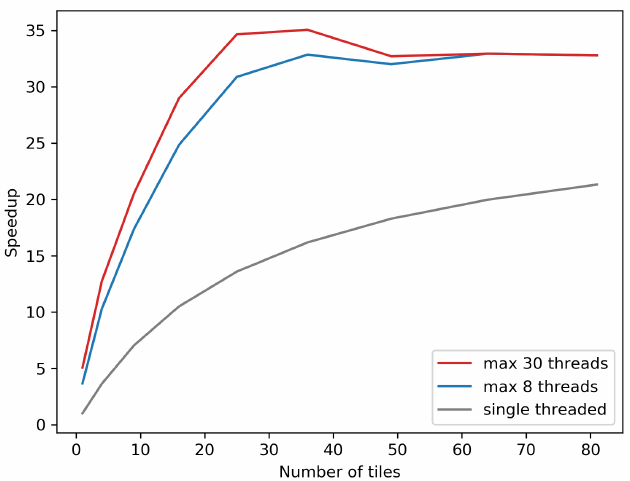
Figure 6. Speedup in a high-throughput cluster